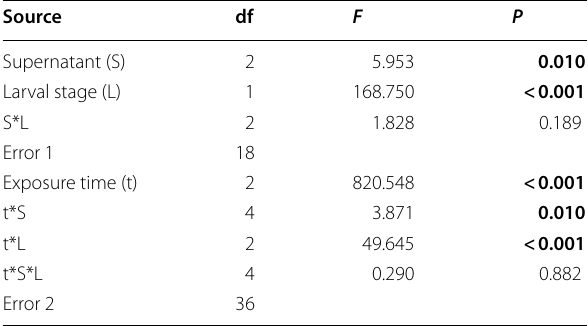
Bold numbers indicate statistical significance at level alpha